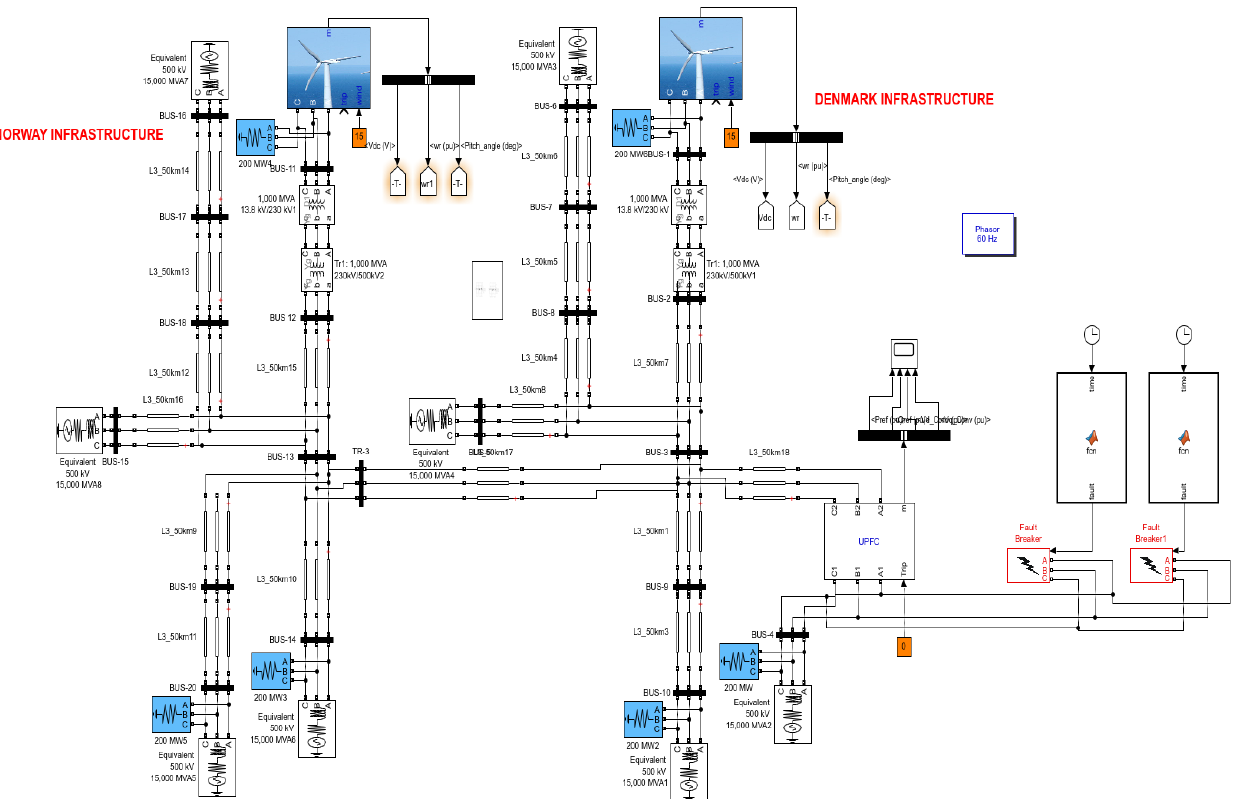
Figure 12. SIMULINK model of 21-BUS SSG.